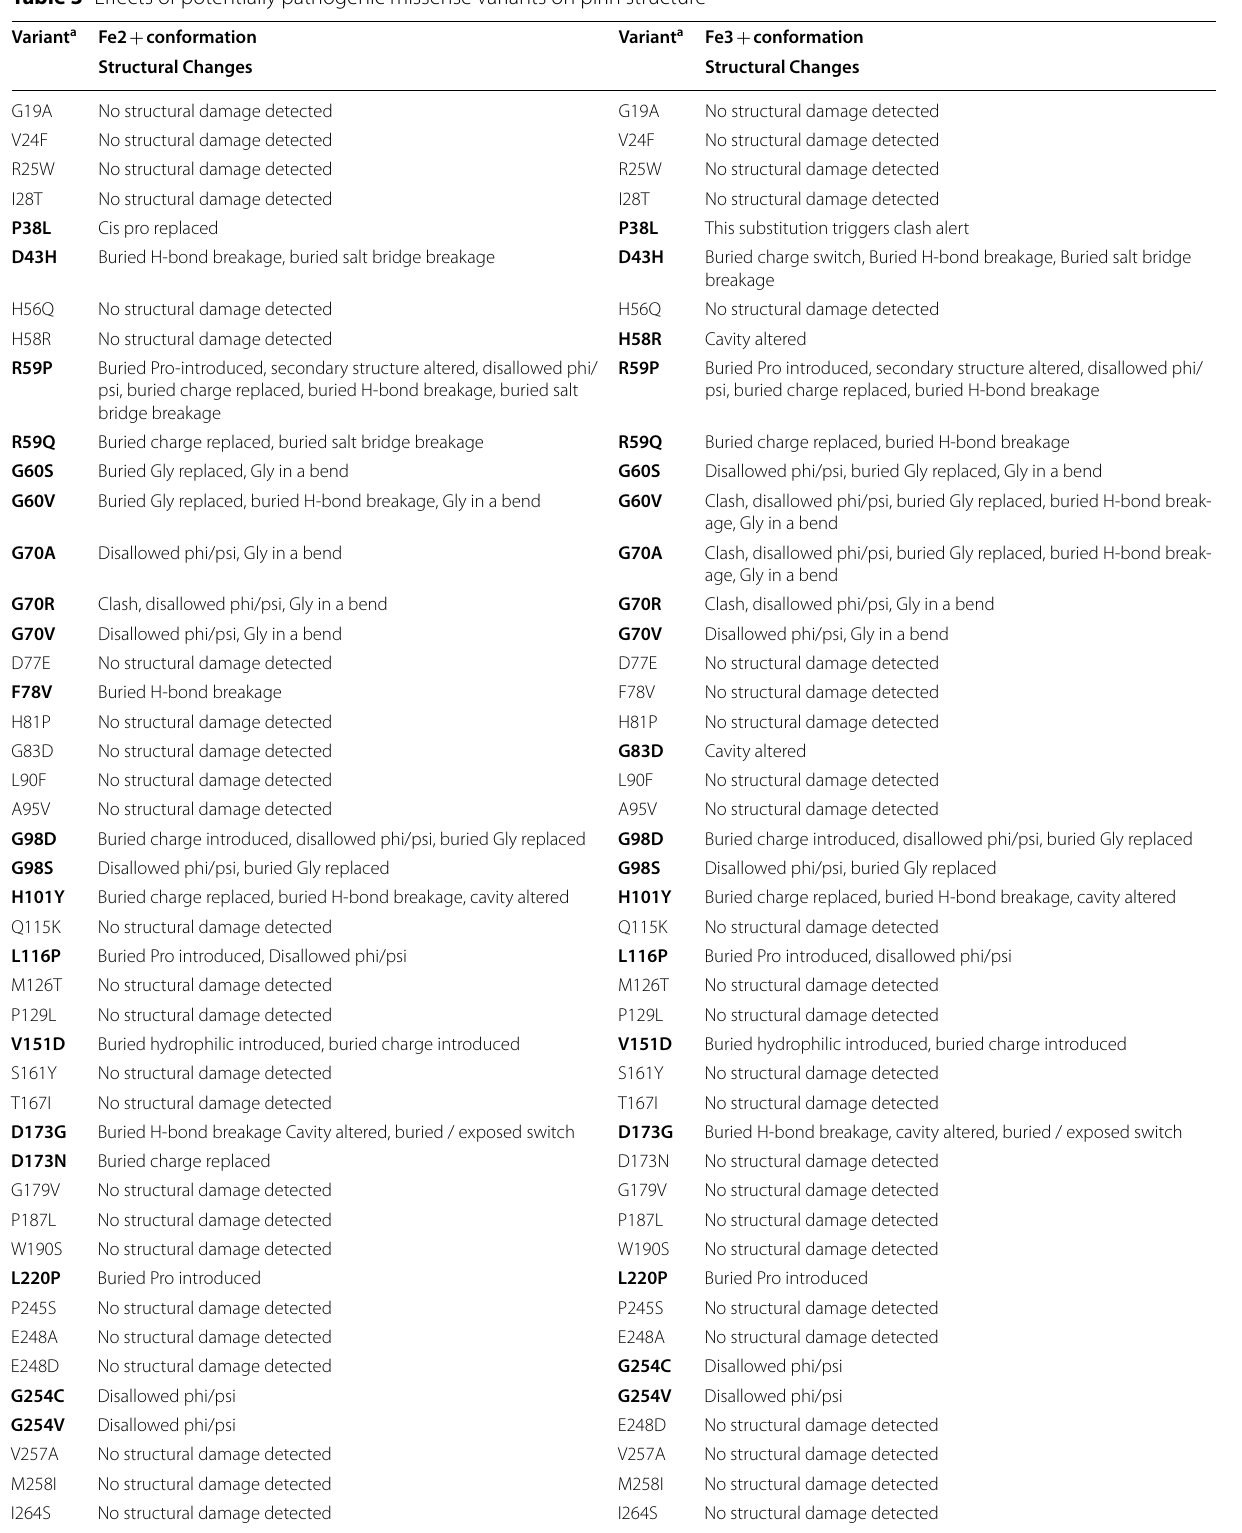
Table 3 Effects of potentially pathogenic missense variants on pirin structure Variant a Fe2 +